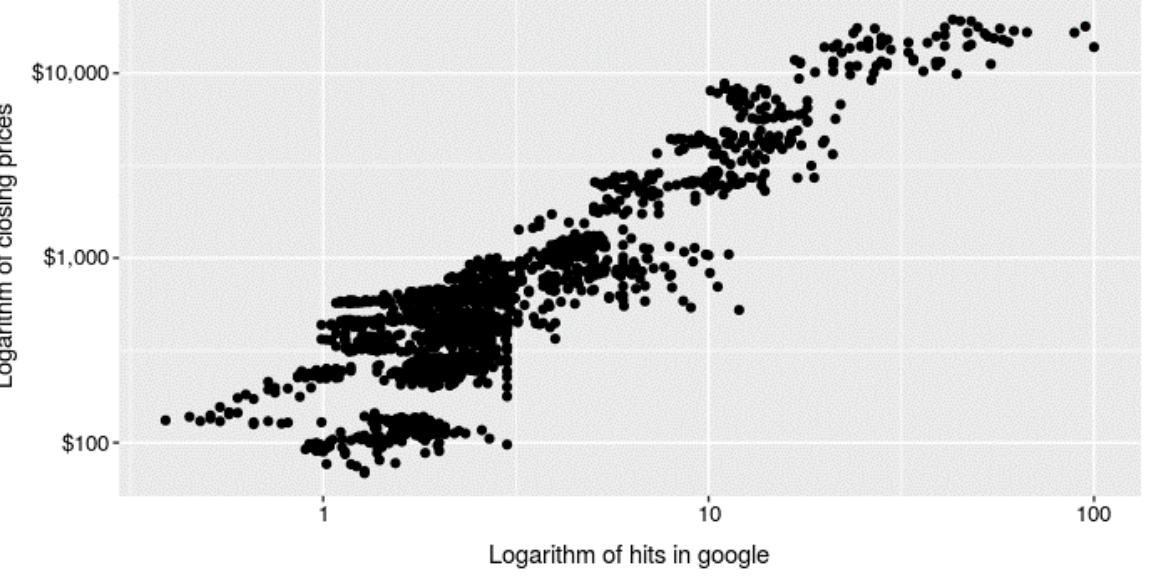
Figure 1: Google trends hits vs Bitcoin